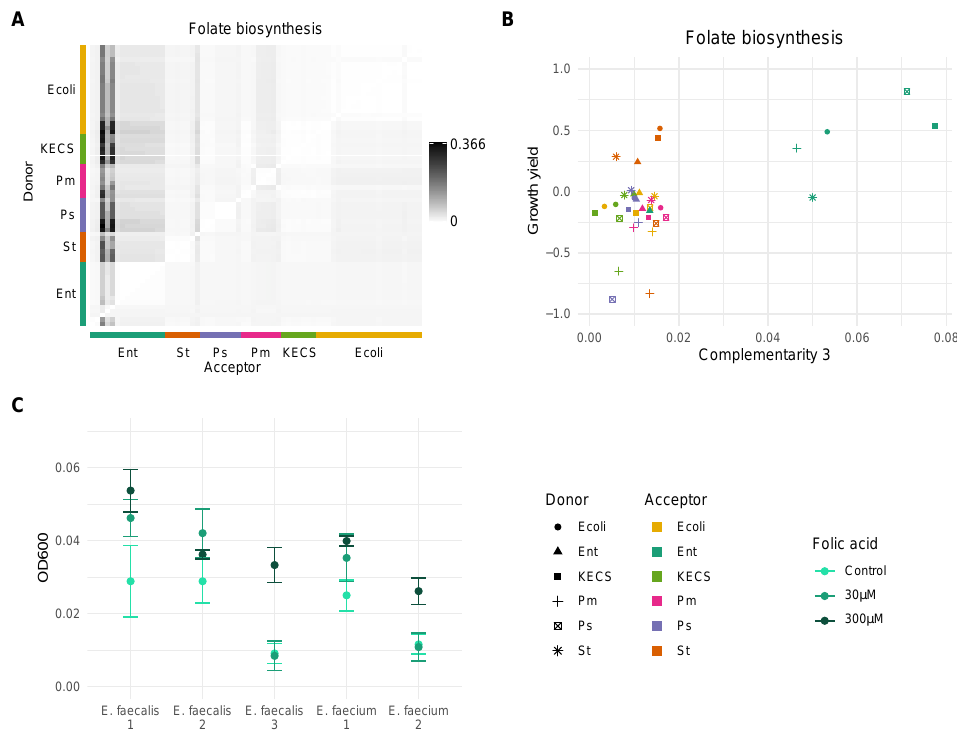
Figure 5. Folate complementarity. ( A ) Heatmap of Complementarity 3 for the pathway. ( B ) Entero- cocci as acceptors have higher complementarity for folate biosynthesis and increased growth yield values. ( C ) Supplementation of artificial urine medium with folic acid increases the growth yield of different E. faecalis and E. faecium isolates. Statistical significance was assessed with a t -test ( p < 0.05), with Bonferroni correction to correct for multiple comparisons. All isolates, except E. faecalis 1, had a significant growth increase for at least one assessed folic acid concentration; E. faecalis 2 (30 µ M), E. faecalis 3 (300 µ M), E. faecium 1 (30 µ M), E. faecium 2 (300 µ